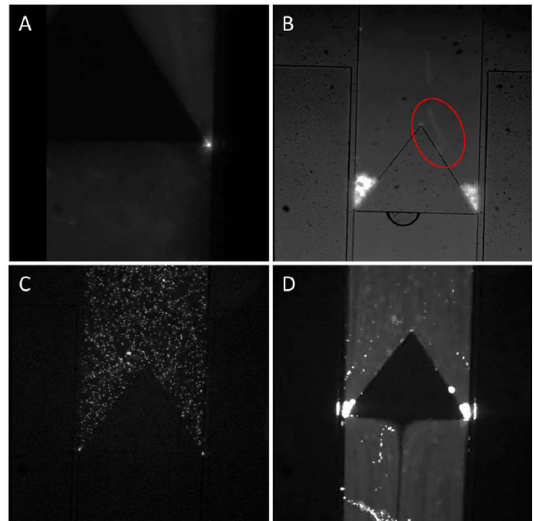
Figure 6. Fluorescent images depicting the flow of fluorescent bead through the semi-always-closed single-layer valve. ( A ) 0.2 μm fluorescent beads diffusing through the valve side opening. ( B ) 10 μm fluorescent beads getting trapped in the microfluidic valve, we can see that the fluid continues to flow due to the shade of a flowing bead (red circle). ( C ) 5 μm fluorescent bead initially getting trapped before actuation of the single layer valve. ( D ) 5 μm fluorescent bead passing through the single layer valve once the side wall was deflected.